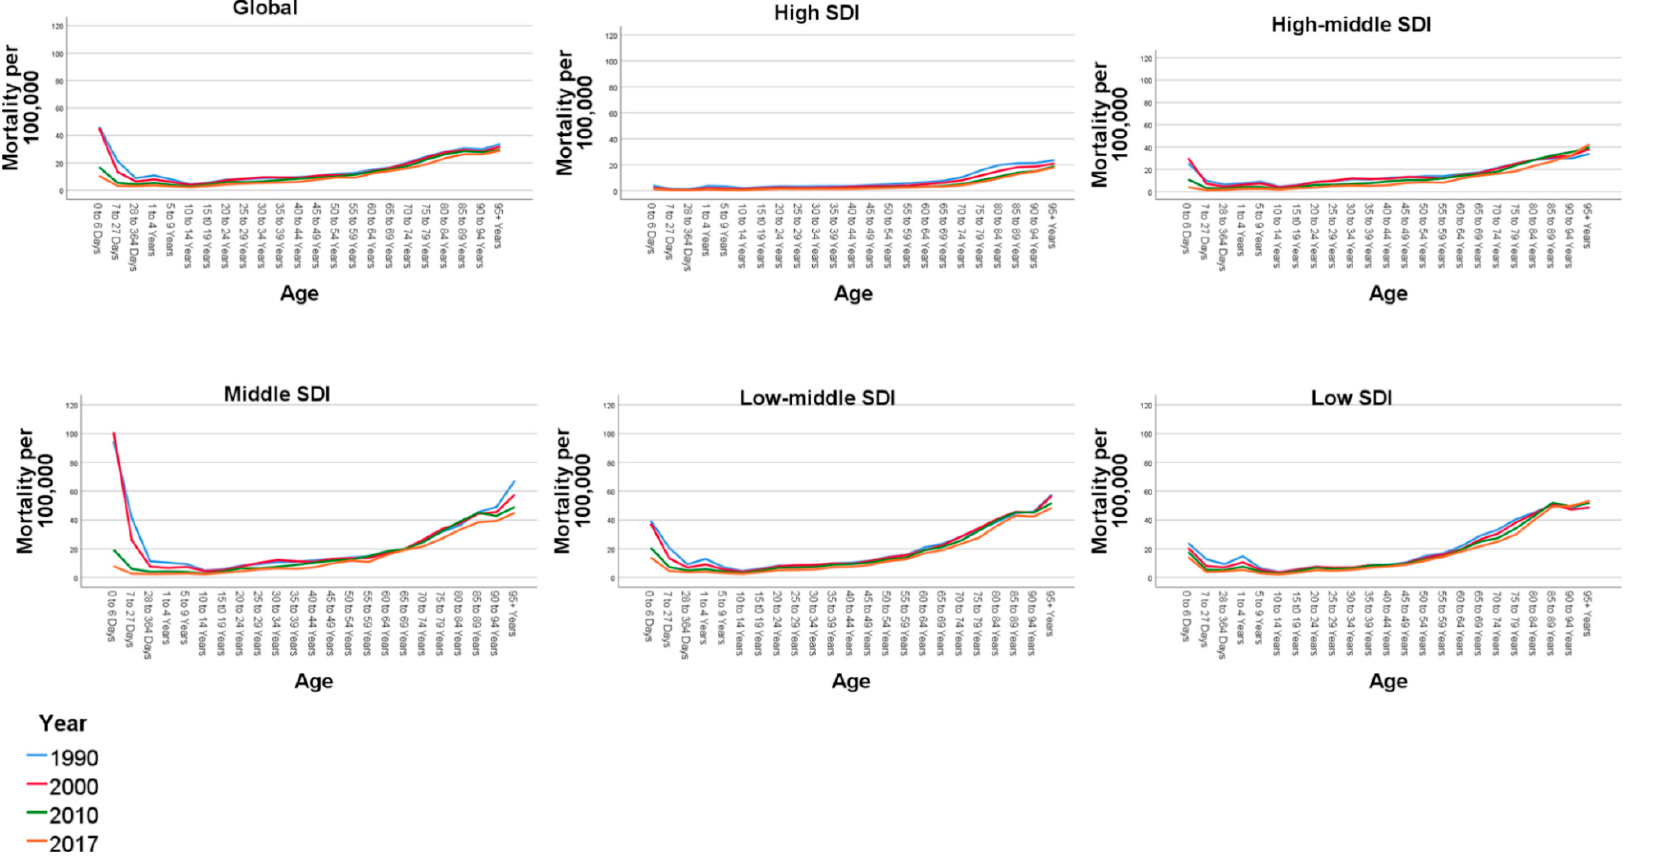
Figure 4. Trends for age-specific mortality rates for pedestrian road traffic injuries per 100,000 across sociodemographic indices 1990 – 2017.